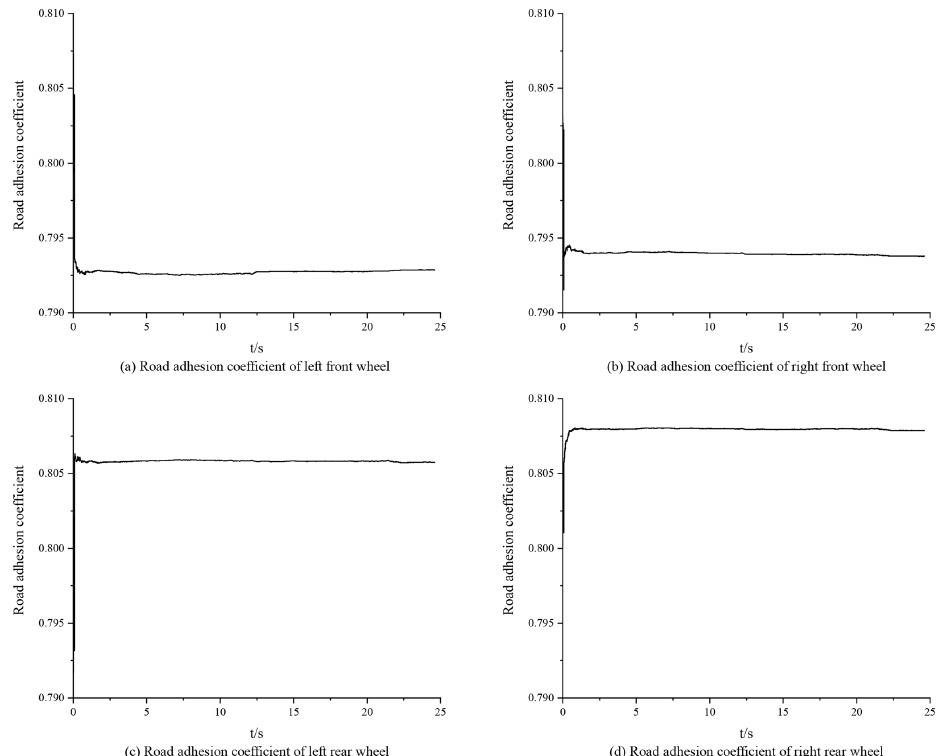
Figure 15. Road surface identification effect of double-lane-changing